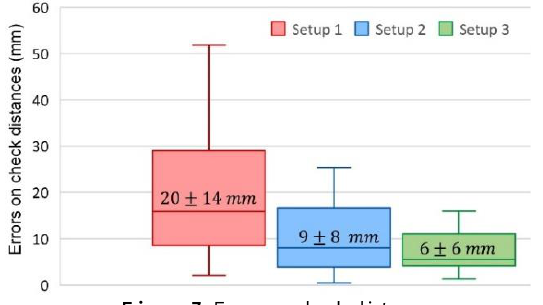
Figure 7 : Error on check distances. Figure 8: Fitting a linear model for predicting the error of local measurements